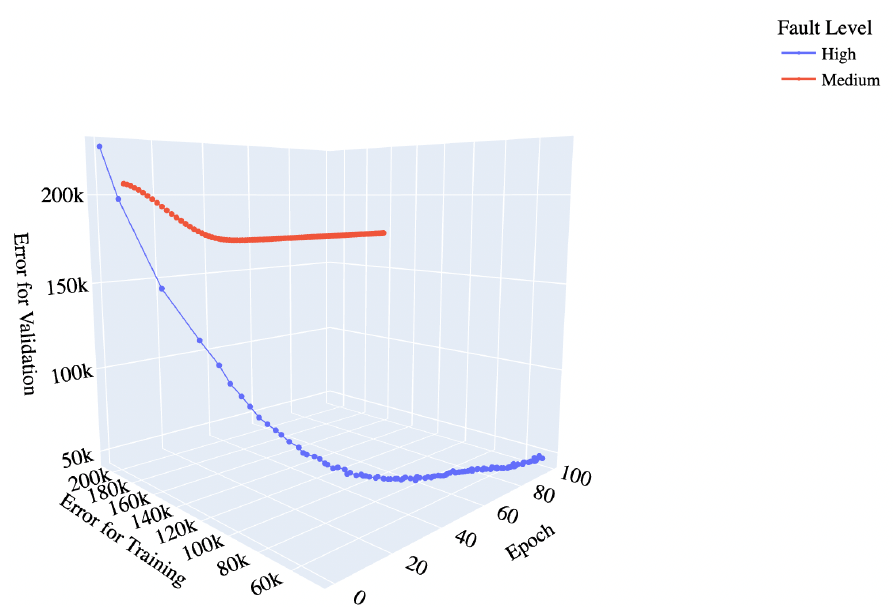
Figure 19. The estimated error between validation and training as comparison results in case of 30% testing